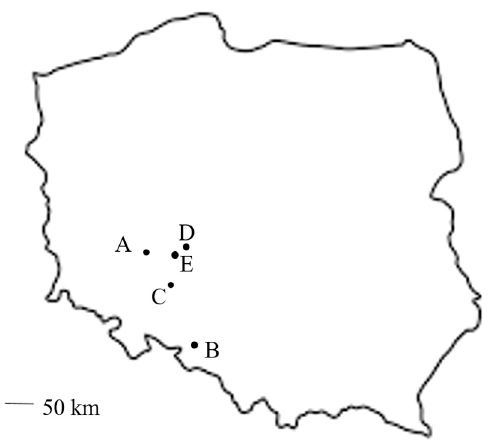
Figure 1. Localities of Aeolothrips intermedius sampling in the southwest of Poland.